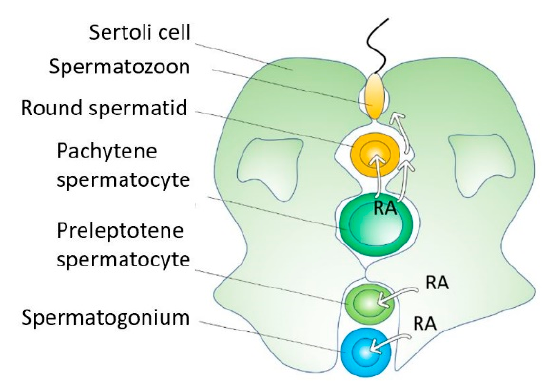
Figure 4. During spermatogenesis, RA controls spermatogonial proliferation and differentiation, meiotic initiation, spermatid elongation, and sperm release. Spermatogonial stem cells undergo self-renewal or proliferate and differentiate to enter meiosis in response to RA.